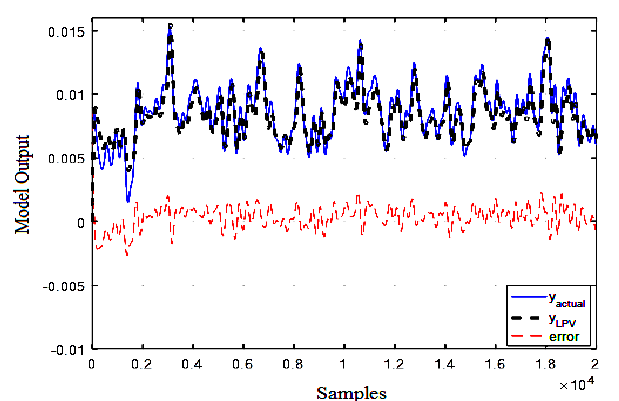
Fig. 8. Estimation and validation of LPV steam dump system